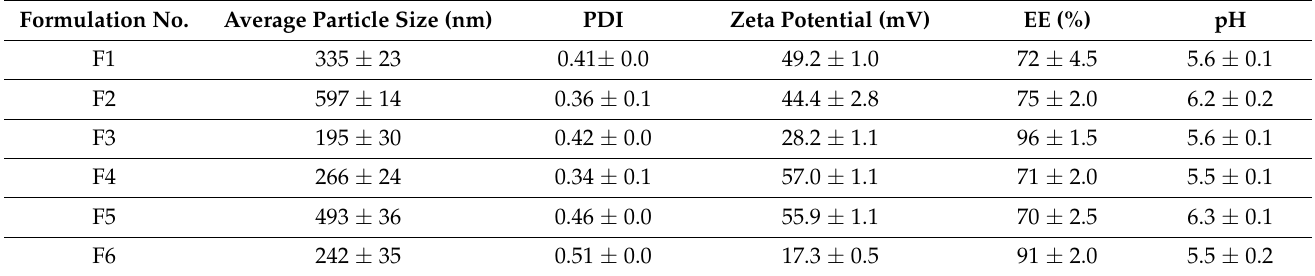
Table 6. Characterization of different MLX-CS-NPs.